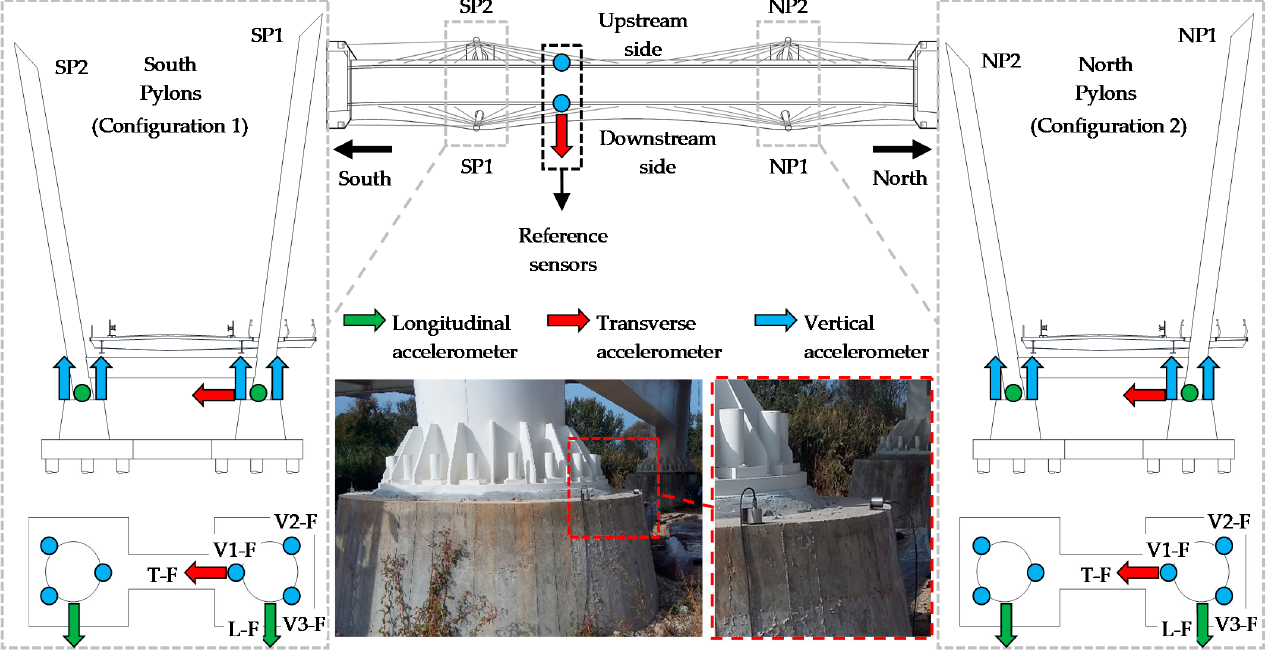
Figure 5. Dynamic proof test instrumentation and sensor arrays: ( a ) accelerometers layout for AVTs, ILTs, and BLTs, ( b ) pictures that are relevant to the adopted instrumentation, and ( c ) truck passing over a bump during ILTs.